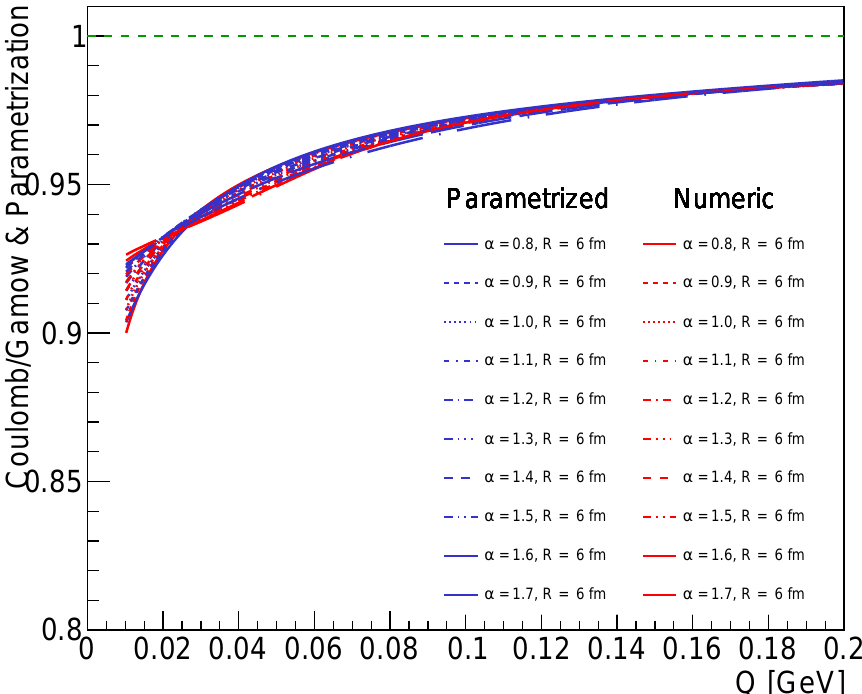
Figure 1. An example for the basic parametrization for a given R and different α s. One can observe that the α dependence is quite weak but still observable and quite